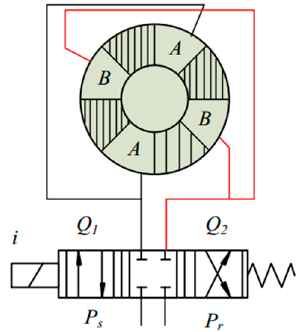
Figure 3. The electro-hydraulic actuator schematic.